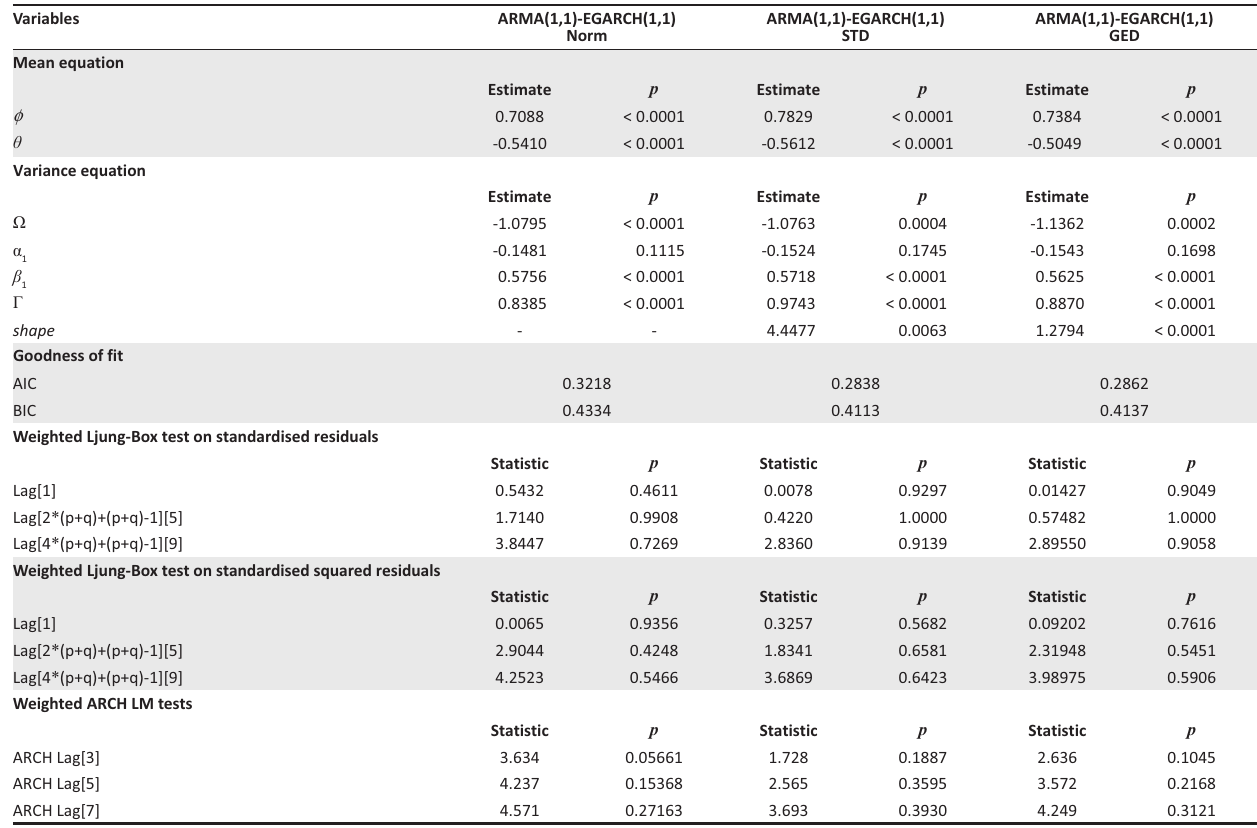
ARMA, autoregressive moving average; EGARCH, exponential generalised autoregressive conditional heteroscedasticity; GED, generalised error distribution; ARCH, autoregressive conditional heteroscedasticity; LM, Lagrange Multiplier; AIC, Akaike information criterion; BIC, Bayesian information criterion. FIGURE 4: ARMA(1,1)-EGARCH(1,1) model